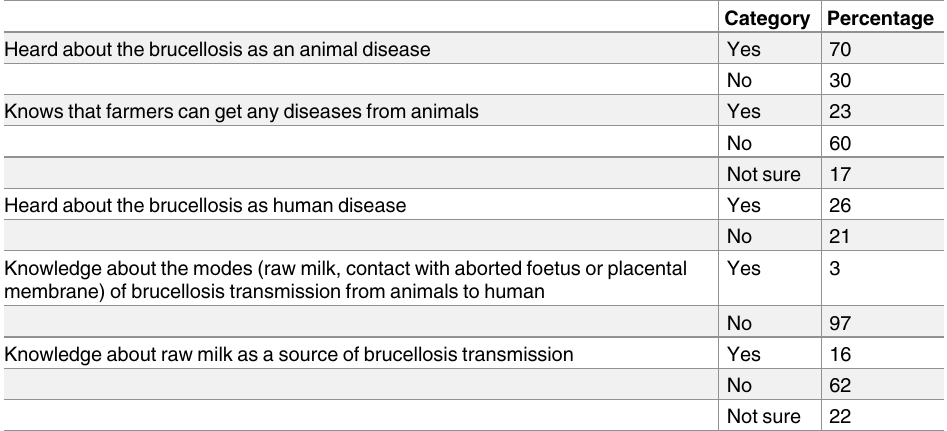
Table 4. Knowledge and understanding about brucellosis among smallholder dairy farmersof Paki- stan participating in a cross-sectional study on brucellosis ( n = 420 farmers)